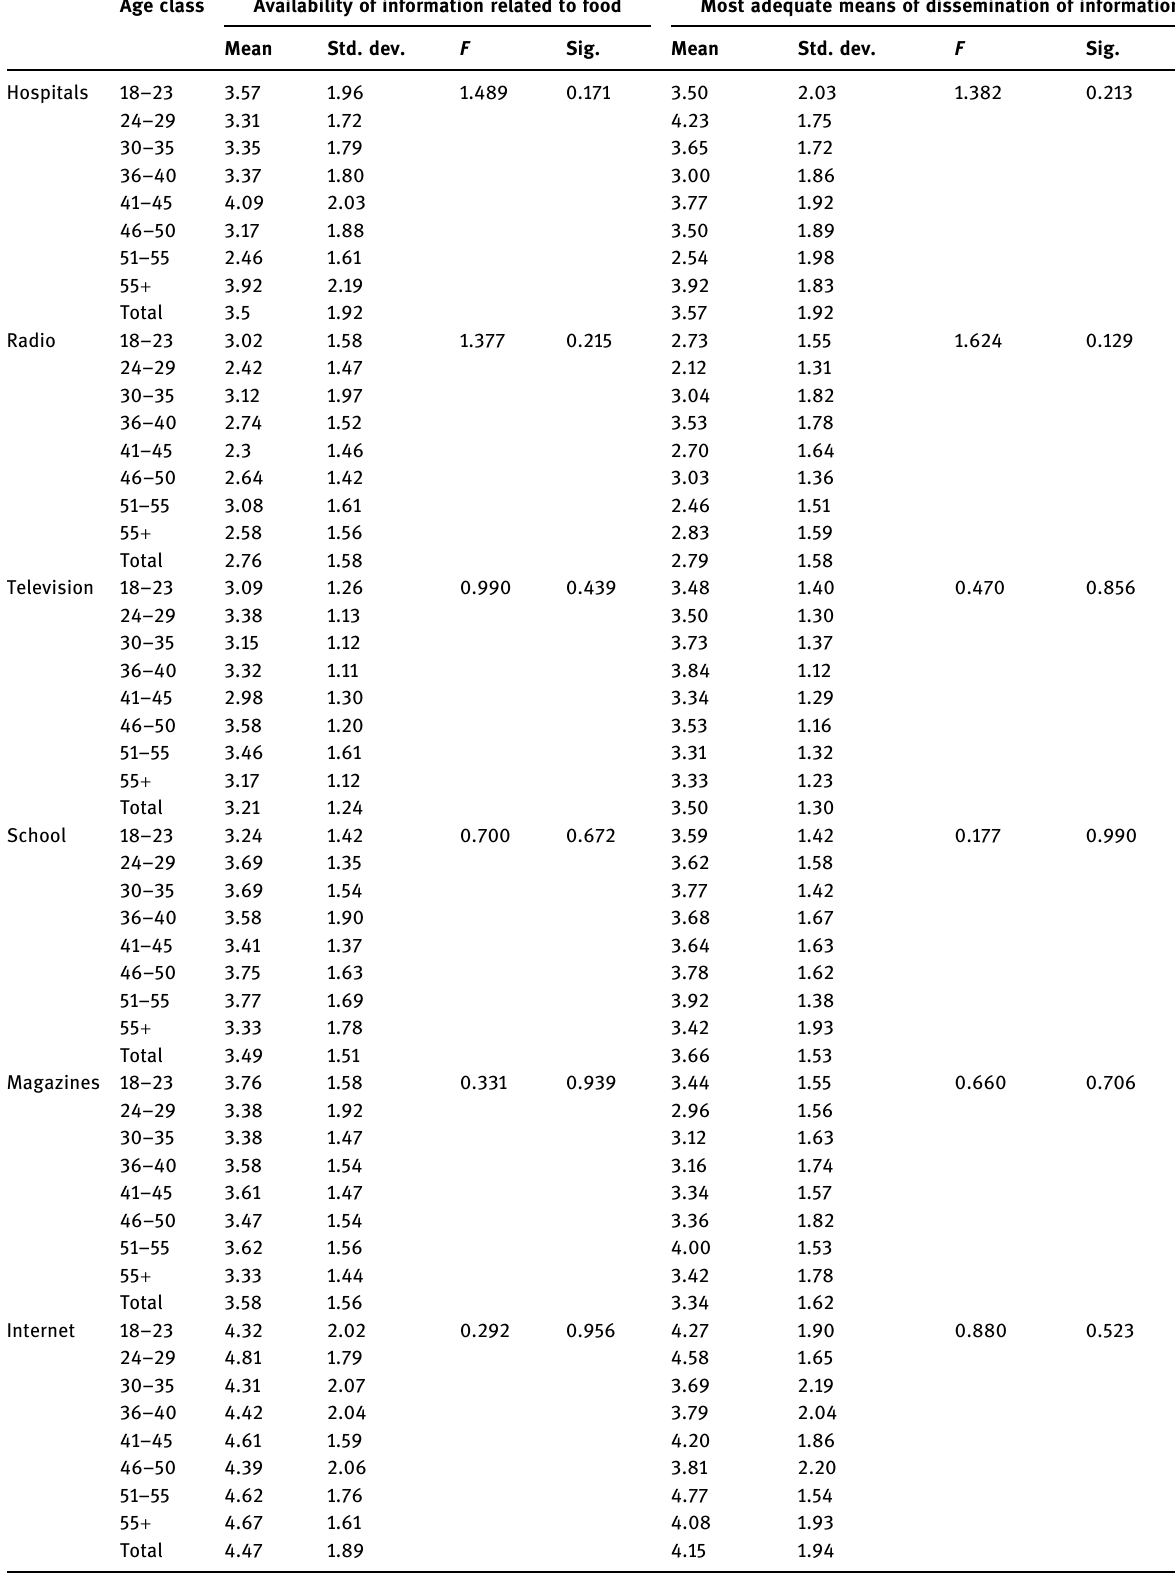
Table 5: Statistical results of ANOVA made to the in fl uence of age on the availability of information related to food and on the most adequate means of dissemination of information Age class Availability of information related to food Most adequate means of dissemination of information Mean Std. dev. F Sig. Mean Std. dev. F